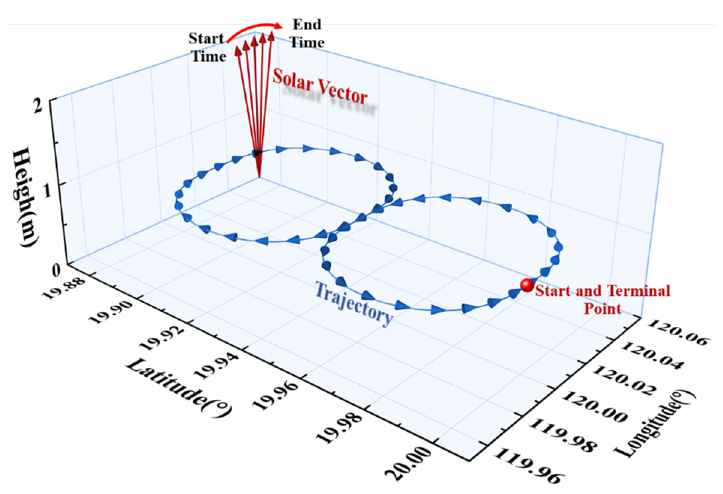
Figure 11. The simulation trajectory.